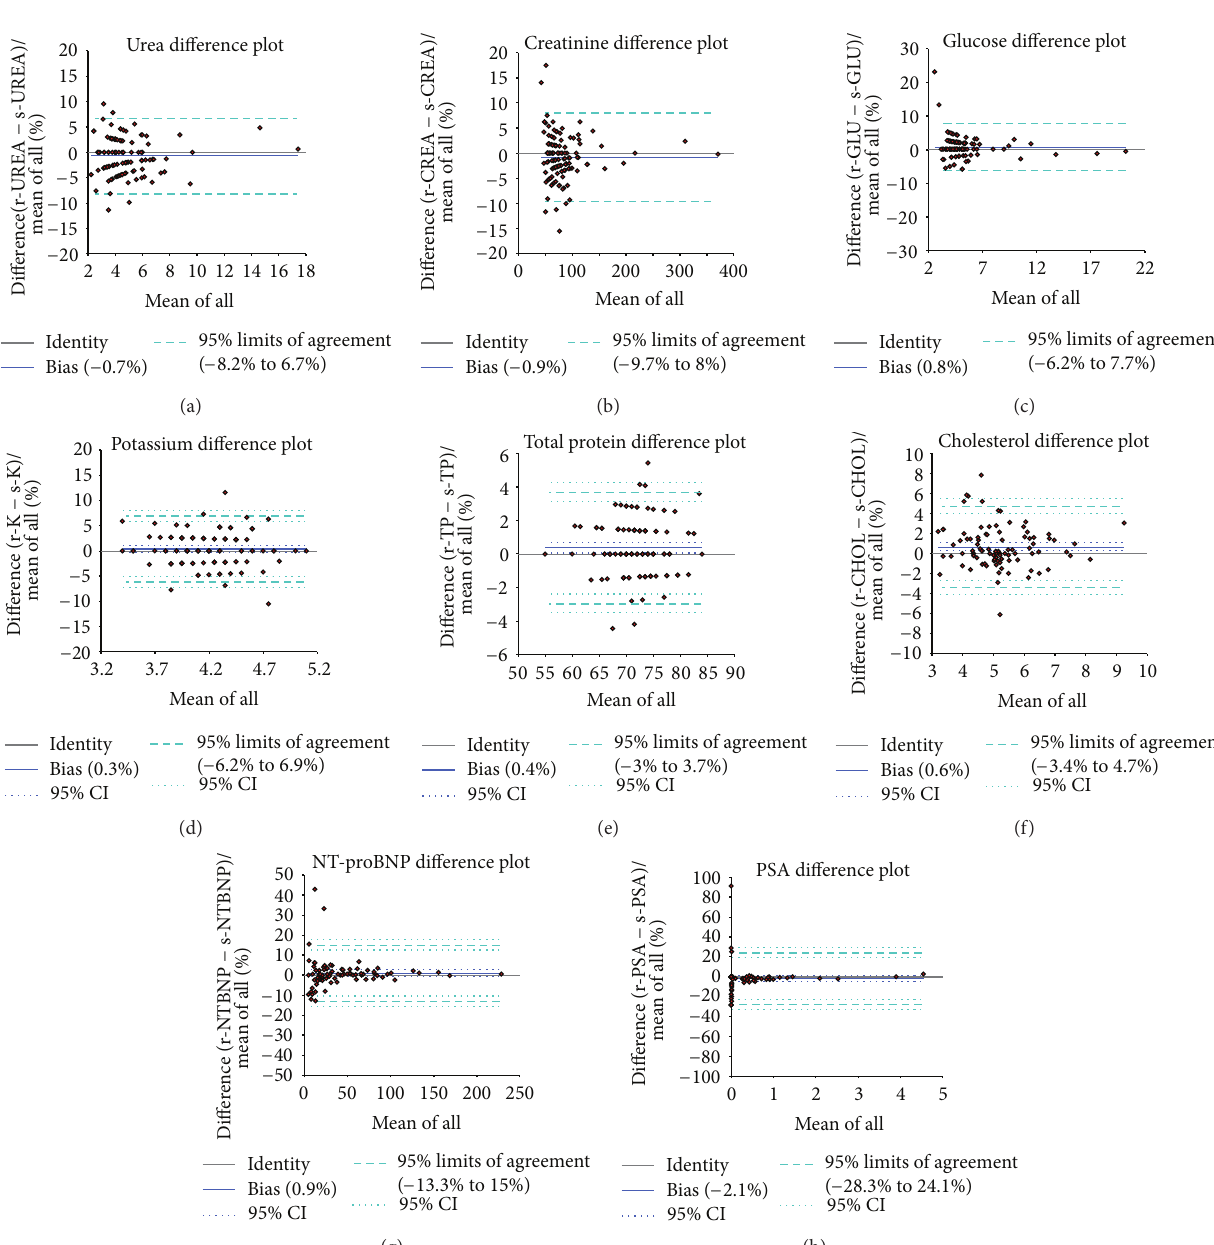
Figure2:Bland-Altmandifferenceplotsforselectanalytes.Selectanalytes:(a)urea,(b)creatinine,(c)glucose,(d)potassium,(e)totalprotein, (f) cholesterol, (g) NT-proBNP, and (h)